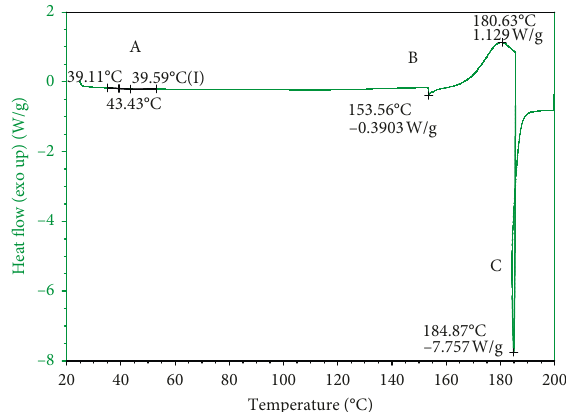
Figure 5: DSC thermograms for samples of Zn 2+ chlorophyllin microencapsulated using agave FOS as a carrier agent, where a T g value of 39.59 ° C was identified. Zones of crystallisation (A), fusion (B), and degradation (C) were also identified.